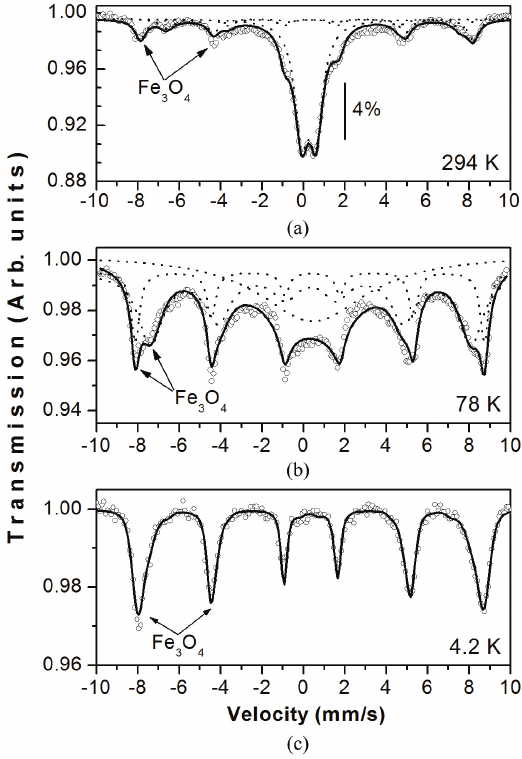
Figure 2. Mössbauer spectrum: (a) room temperature, (b) 78 K e (c) 4.2